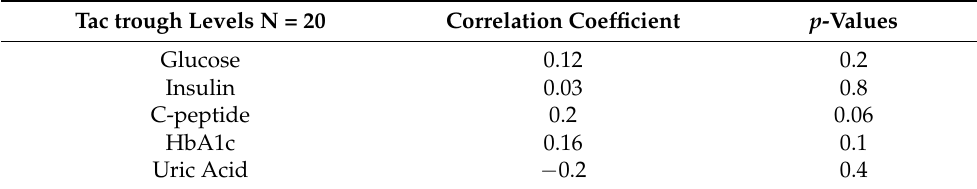
Table 4. Correlations among Tac levels and metabolic parameters in clinically stable kidney trans- plant patients. Tac trough Levels N =